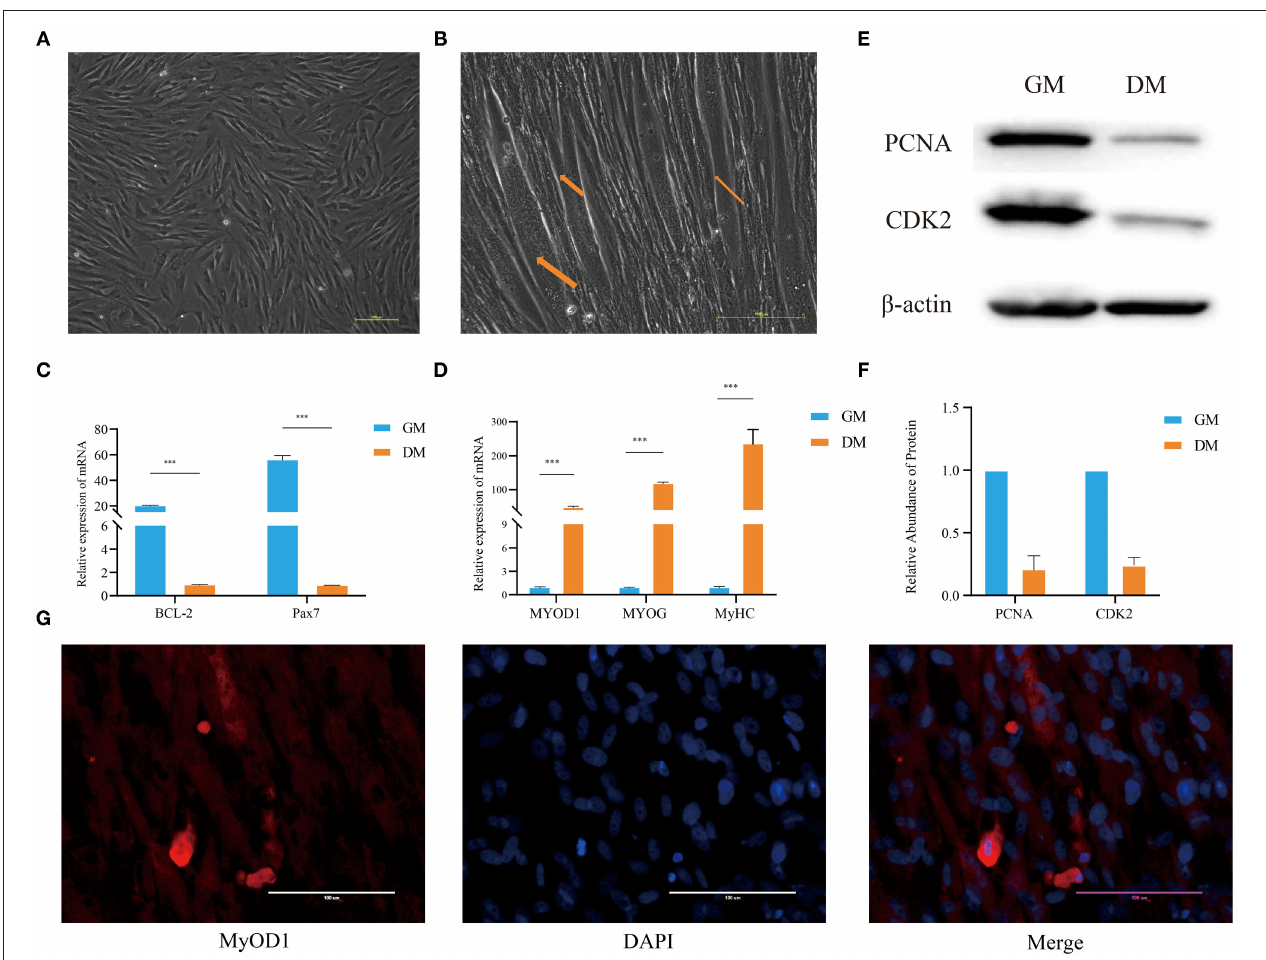
FIGURE 1 | Analysis of the characteristics of buffalo MuSCs during proliferation and differentiation. (A) Proliferation phenotype of muscle stem cells (GM samples). (B) Differentiation phenotype of muscle stem cells (DM samples). (C) MuSCs grown as GM and DM samples were subjected to real-time PCR for BCL-2 and Pax7 . (D) The differentiation phenotype (DM) samples of MuSCs were subjected to real-time PCR for MyoD1 , MyoG, and MyHC . (E,F) MuSCs grown as GM and DM samples were subjected to western blotting for determination of PCNA and CDK2 proteins. (G) The differentiation phenotype (DM) samples of MuSCs were subjected to immunofluorescence for MyOD1 . The data are presented as means ± SD s, n = 3 per group. * P < 0.05; ** P < 0.01; *** P < 0.001. Scale bars = 100/200 µ